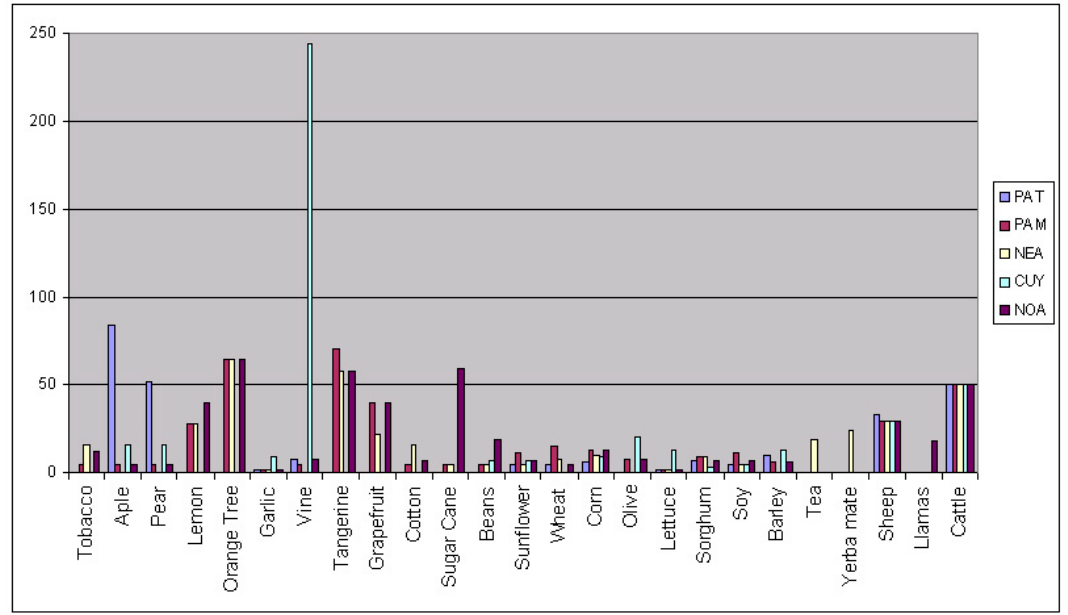
Figure 4. Number of variables for each regional census production. Own elaboration based on the 2018’s census. PAT: Patagonia; PAM: Pampa, Argentina central region; NEA: Argentina North East; CUY: Cuyo; NOA: Argentina North West.